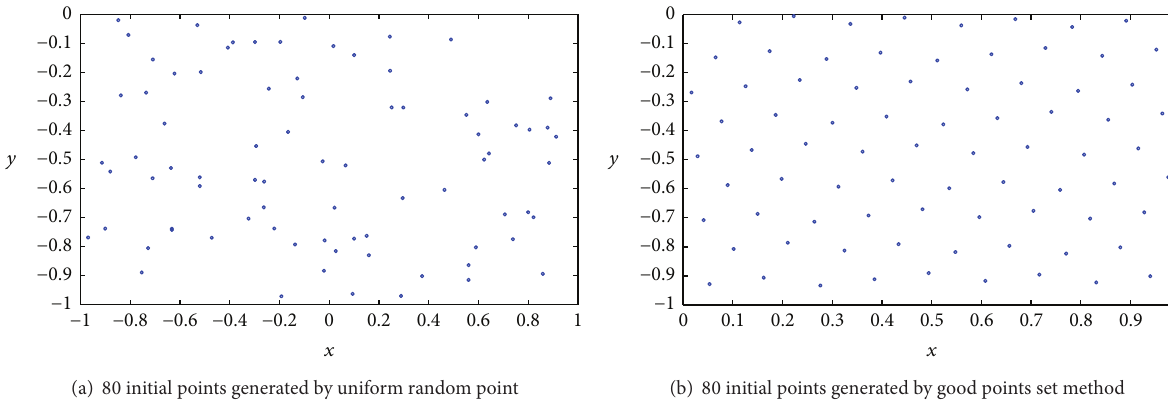
Figure 3: Comparison of good points set method and uniform random